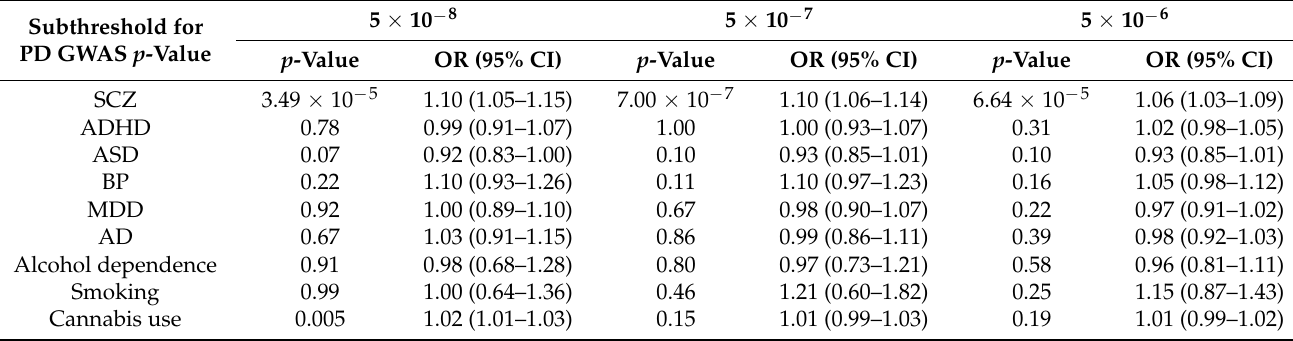
Table 2. Two-sample Mendelian randomization results of Parkinson’s disease and other psychiatric disorders or related traits using the inverse-variance weighted regression. Subthreshold